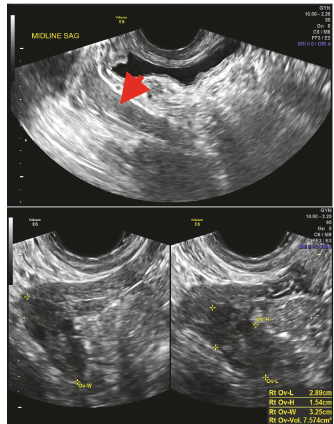
Figure 1: Ultrasound demonstrating bilateral aplastic left (top) and right (bottom) hemiuteri with normal-sized ovaries.